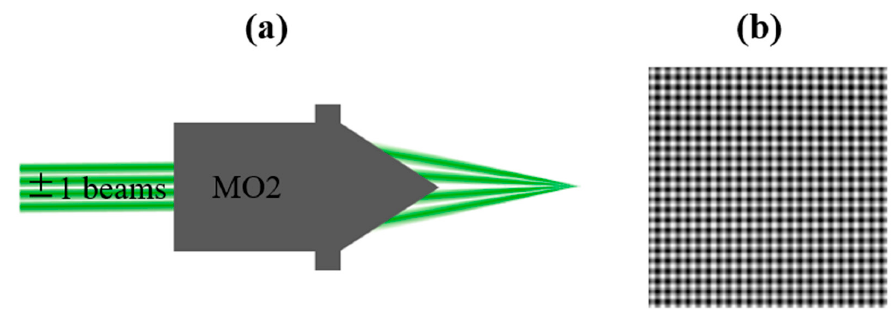
Figure 2. Schematic of the generation of the multifocal arrays. ( a ) The four remaining laser beams are focused by the MO2. ( b ) The multifocal array generated by the interference and overlap of the four laser beams.